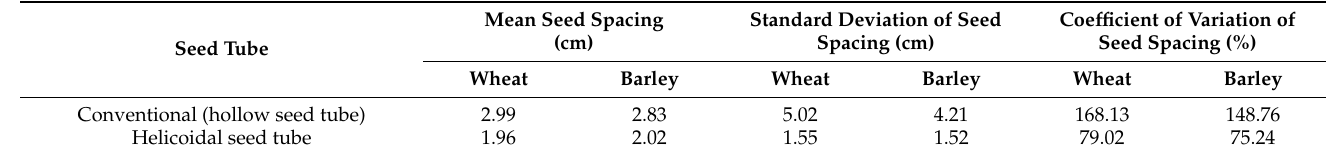
Table 7. The influence of seed tubes on seed distribution uniformity, as indicated by the mean seed spacing and its corresponding standard deviation and coefficient of variation as tested in the laboratory.